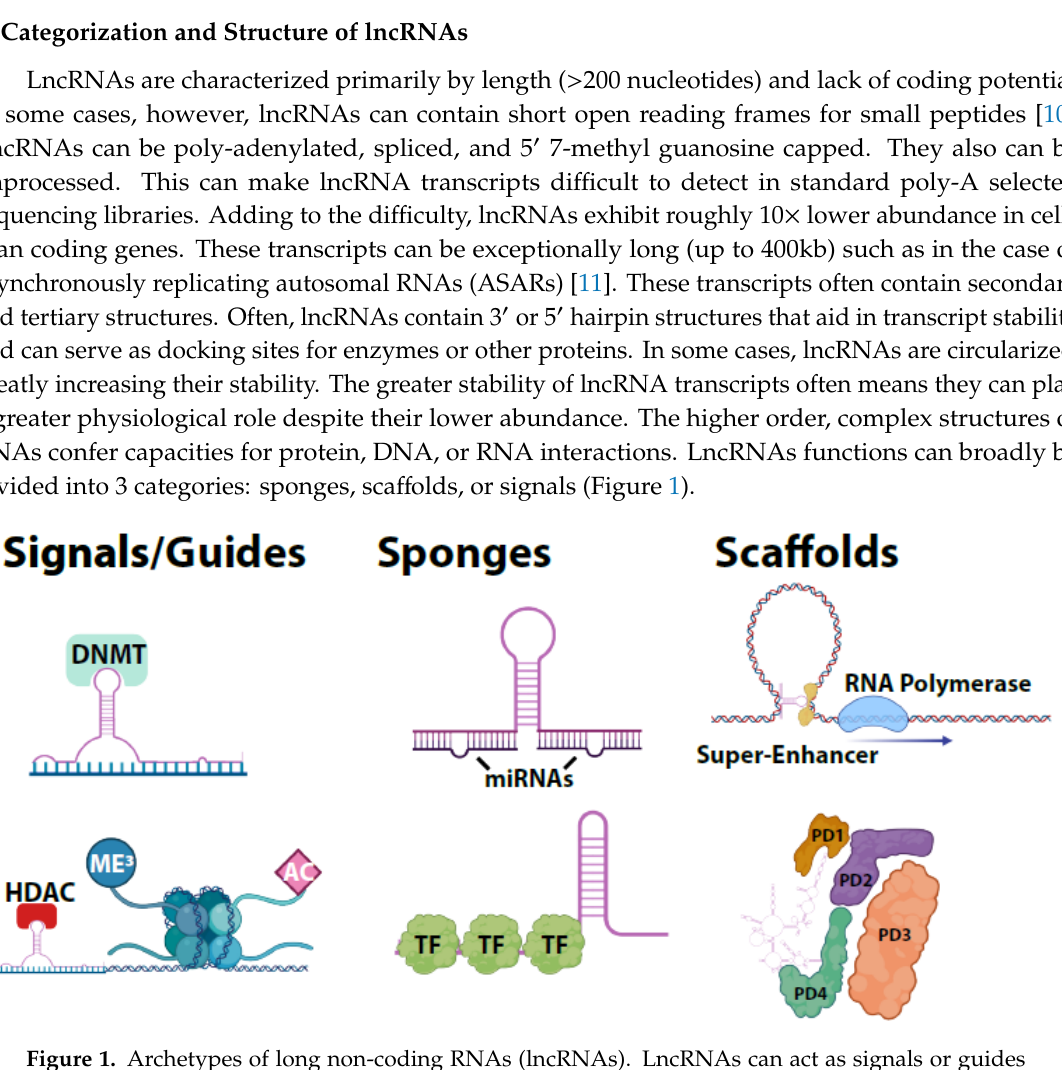
Figure 1. Archetypes of long non-coding RNAs (lncRNAs). LncRNAs can act as signals or guides directing the initiation or repression of transcription. LncRNAs can act as molecular sponges binding miRNAs or transcription factors / proteins. LncRNAs can act as sca ff olds to form enhancer